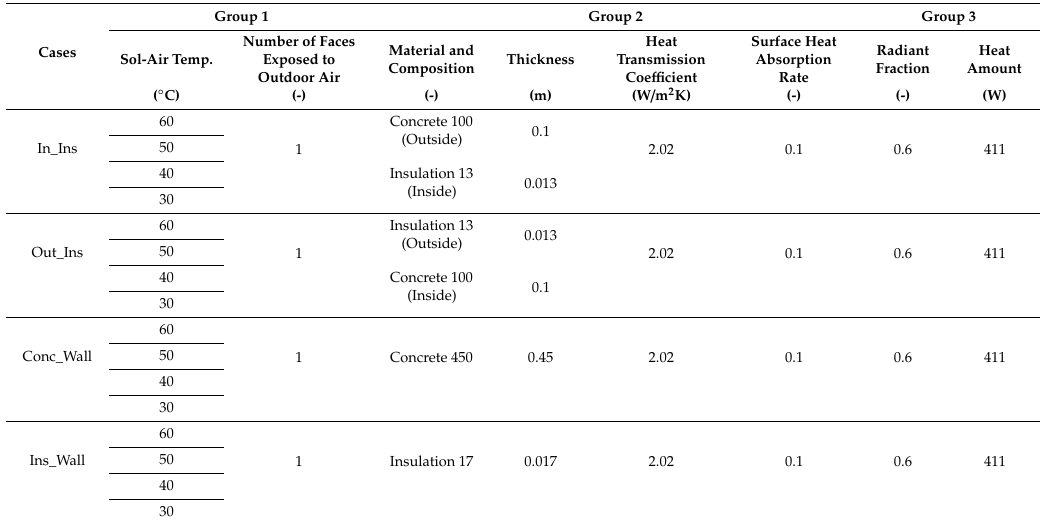
Table 9. Cases for material and composition of wall.